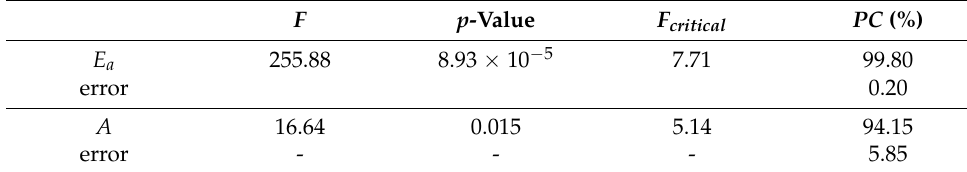
Table 2. Analysis of variance